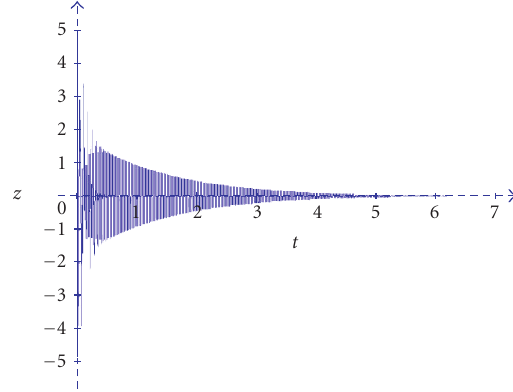
Figure 6.2 . Stable solution of (5.2) in the point A (520,100), a 0 = 5.